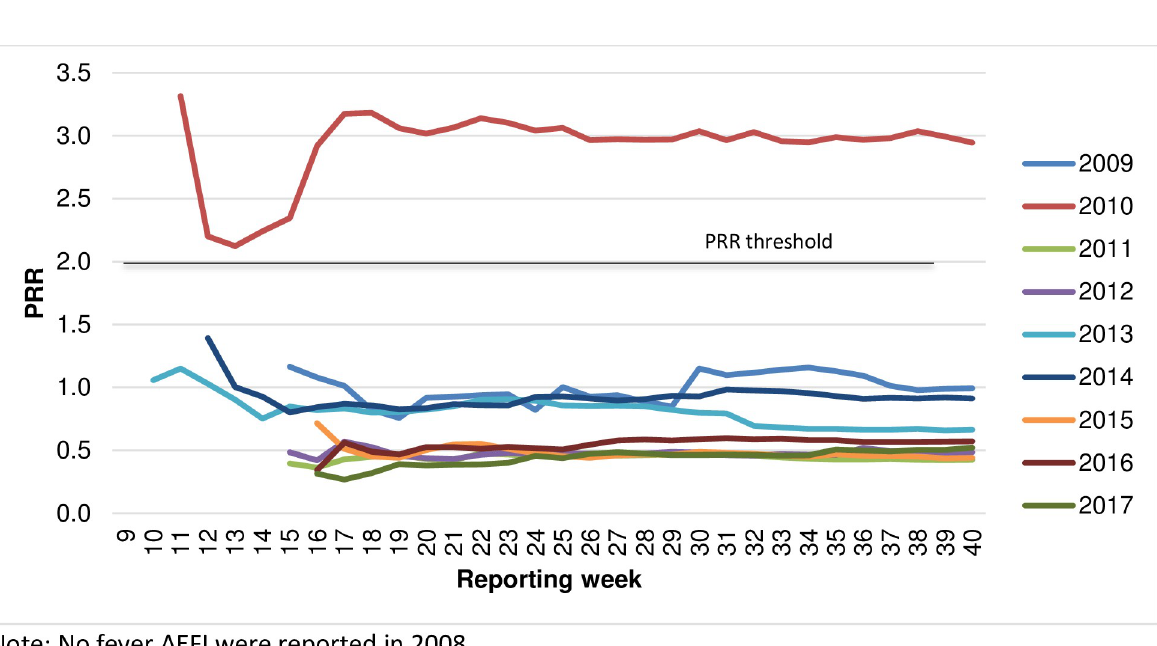
investigation (2010, 2012 and 2016) and not at all in the signal event year of 2015. Signal threshold was reached in 2015 for the 5 years and older age subgroup, but one week later and at a lower magnitude (PRR = 2.48) compared to analysis across all ages. Cumulative analysis using all previous year data did not reach signal detection thresholds in either age subgroup. Sub-analysis comparing individual influenza vaccine brands with the other brands, for allergic AEFI in 2015 shows that the proportional reporting of allergic AEFI with Vaxigrip 1 , Sanofi Pasteur and Influvac 1 , Solvay Pharmaceuticals were significantly higher than for Flu- vax 1 and Fluarix 1 , GlaxoSmithKline that year (Fig 9). Sub-analysis removing signal year data from the all previous years cumulative denominator when calculating PRR for subsequent years did not elicit any additional signal detections.